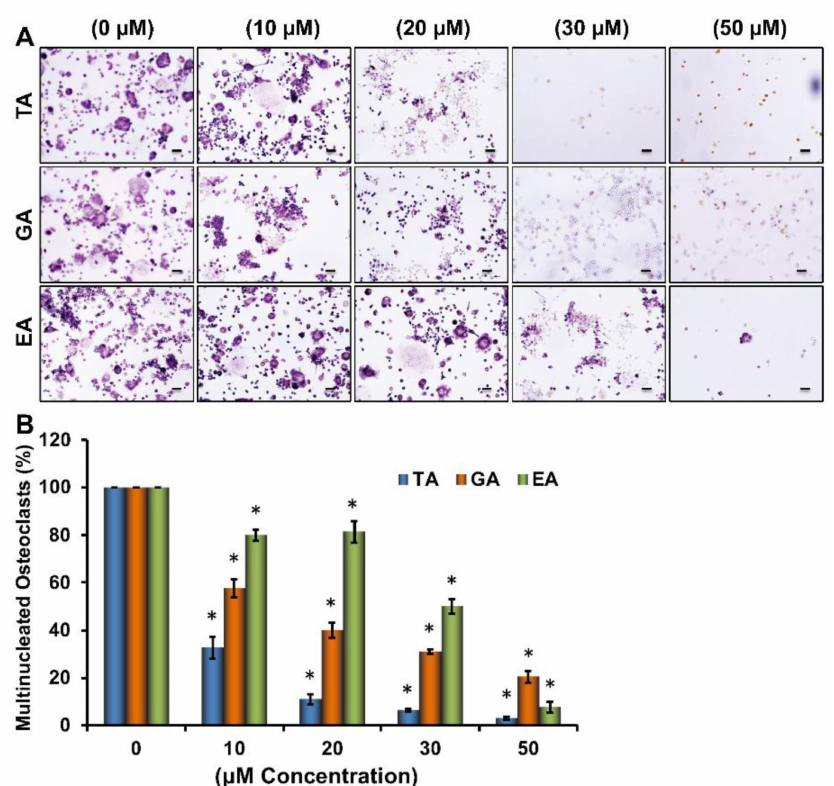
Figure 1. Dose-dependent inhibition of osteoclast differentiation by polyphenolic compounds. ( A ). Images of osteoclast differentiation as identified by TRAP staining at day 6 in the absence or presence of stated concentrations of tannic acid (TA), gallic acid (GA), and ellagic acid (EA) during osteoclast differentiation (Scale bar = 20 µ m). ( B ). The number of TRAP-positive multinucleated osteoclasts present in each group shown graphically in the absence or presence of stated concentrations of stated polyphenolic compounds during osteoclast differentiation. * p < 0.05 indicates statistical significance between control vs. TA, control vs. GA, control vs.